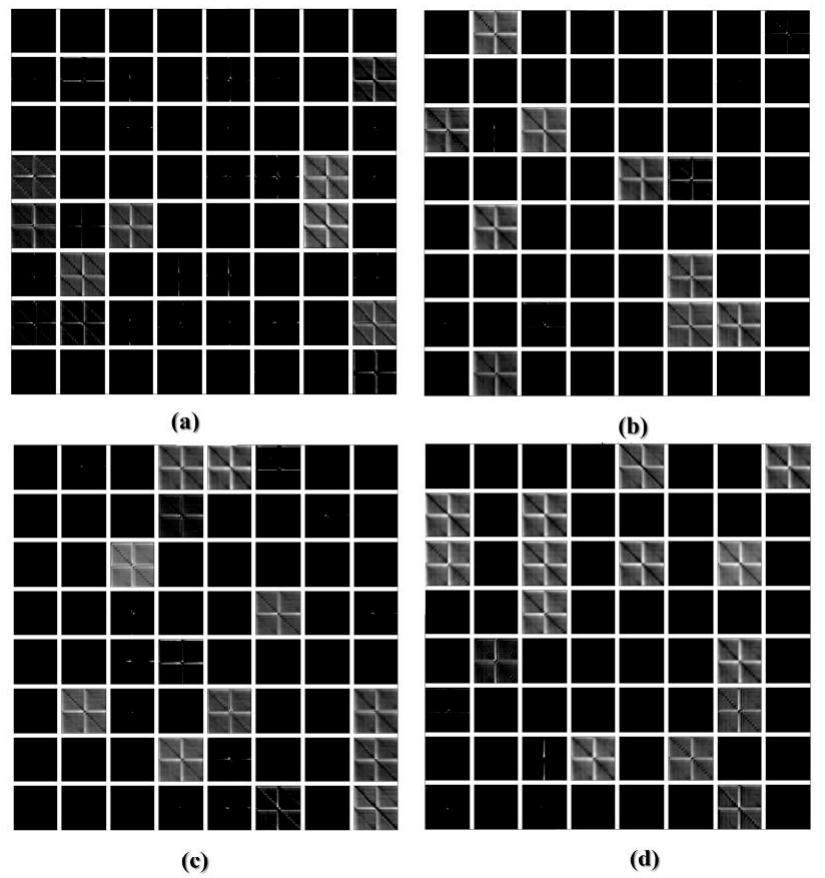
Figure 13. Feature maps for the 7th CNN layer after applying 64 kernels into PZT#2 frames for the structural conditions: ( a ) Healthy (H); ( b ) D1; ( c ) D2; ( d ) D3. Table 2. Results for the CNN method: training and testing phases.